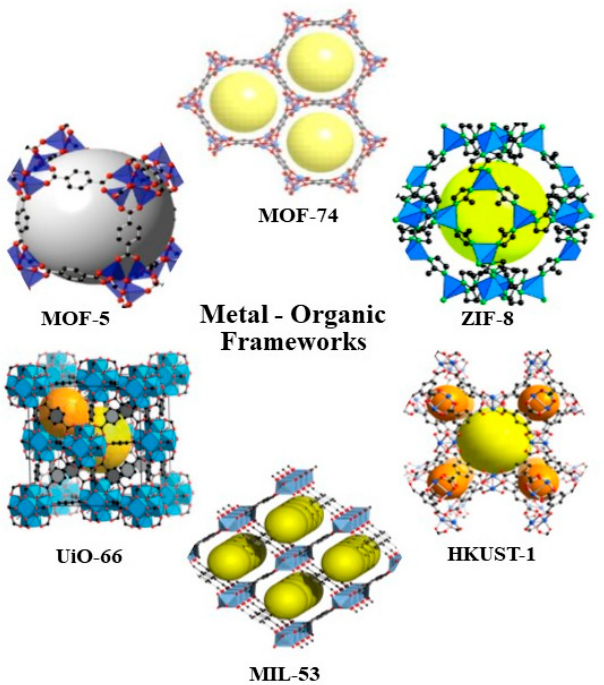
Figure 3. Examples of typical metal − organic frameworks [66].